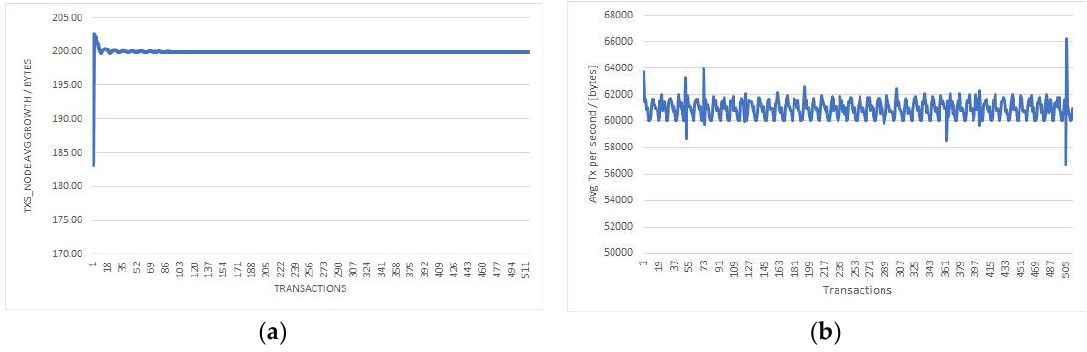
Figure 9. Average transaction size/second ( a ) and average growth in node size ( b ).